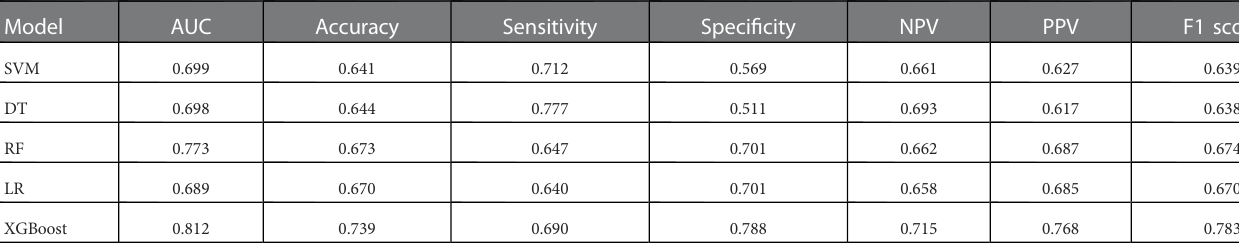
TABLE 2 Performance of predictive models generated by fi ve machine learning models.